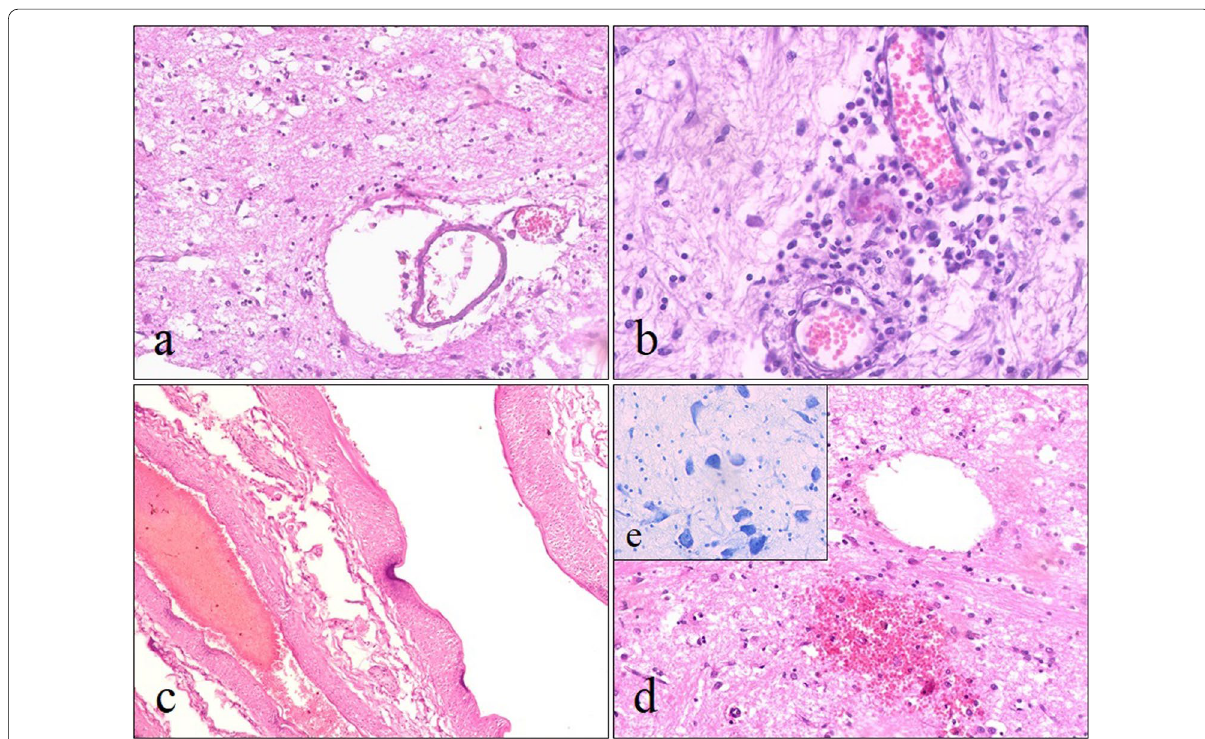
Fig. 2 Histological picture of brain lesions. a , b Inflammatory infiltration, spongy and perivascular edema, areas of necrosis, desquamation of the endothelium in the cerebral vessels. 200. c Fibrinoid necrosis of cerebral vessels. H&E staining. 100. d AHNE with the formation of a cyst. H&E × × staining. 200. e Severe necrobiotic neuronal damage. Nissl staining. × ×